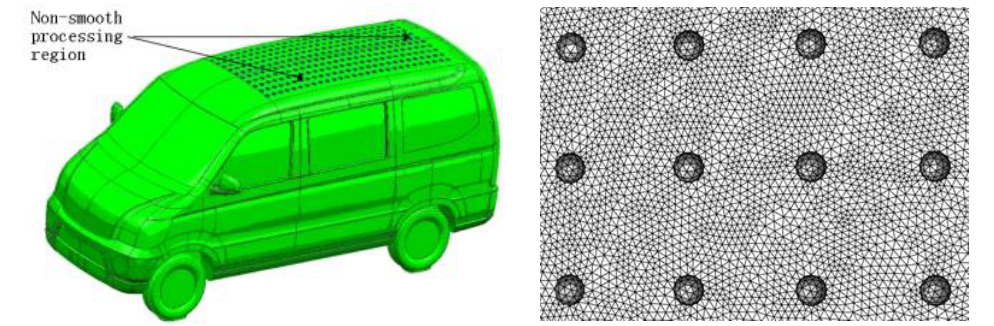
Figure 4. Non-smooth processing region and mesh.